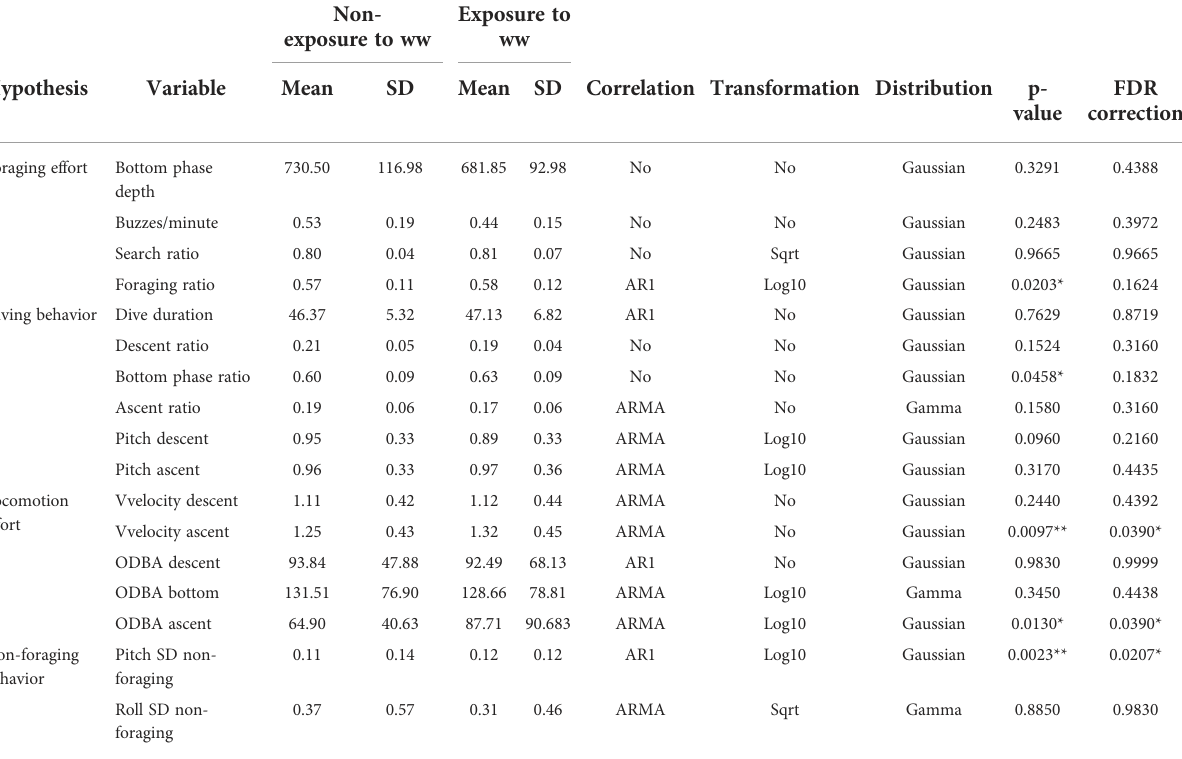
TABLE 2 Mean and standard deviation (SD) of variables used during non-exposure and exposure to whale watching (ww) periods and summary of results from the Linear Mixed-Effect Models testing the effects of ww vessel presence on the four sets of